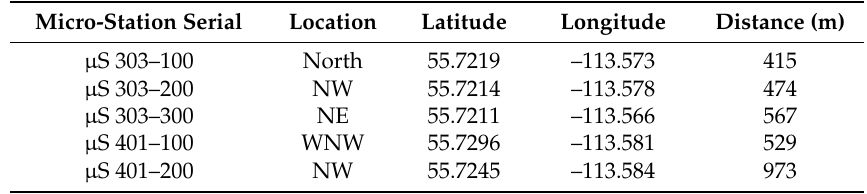
Table 1. Micro-station deployment details. Distances are measured from an assumed center location of the fire-area, shown in Figure